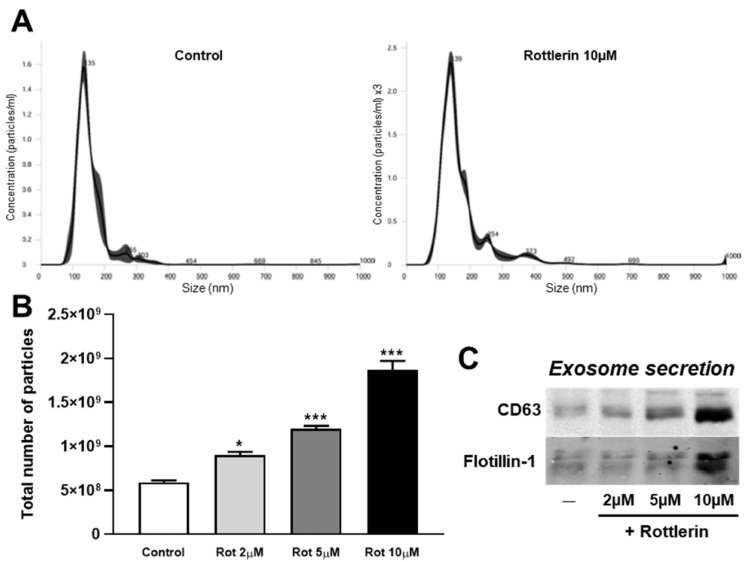
Figure 2. Rottlerin enhances the release of exosomes/microvesicles from C6 cells. The experiments started with the same number of cells. Cells were exposed to LDL (60 µ g/mL of cholesterol) in the presence of 2.5 µ M U18666A for 12 h. The medium was then removed, cells were washed twice, and serum-free medium was added, supplemented with U18666A, and the incubation was continued for 4 h in the presence of increasing doses of rottlerin (2 µ M, 5 µ M, or 10 µ M, Rot). At the end of the incubation, the medium was removed, and the exosomes/microvesicles were isolated and analyzed. ( A ) Exosomes/microvesicles from C6 cells in control conditions or treated with rottlerin were isolated and subjected to nanoparticle tracking analysis. The graphs represent the size (nm) of the exosomes/microvesicles. ( B ) The graph represents the total number of particles per experiment by nanoparticle tracking analysis. Means ± SEM of three measures. ( C ) Flotillin- 1 and CD63 Western blots of exosomes/microvesicles isolated from C6 cells. Results shown are representative of three independent experiments. Statistical comparisons of treatments versus the control (* p < 0.05, *** p < 0.001). Table 1. Effect of rottlerin on sphingolipid contents. Cells were incubated without (Control) or with increased doses of rottlerin (2 µ M, 5 µ M, and 10 µ M) for 4 h. Ceramides, hexosylceramides, and sphingomyelin were measured by mass spectrometry. Results are the mean ± SEM from three independent experiments, expressed in nmol/mg protein. Statistical comparisons of